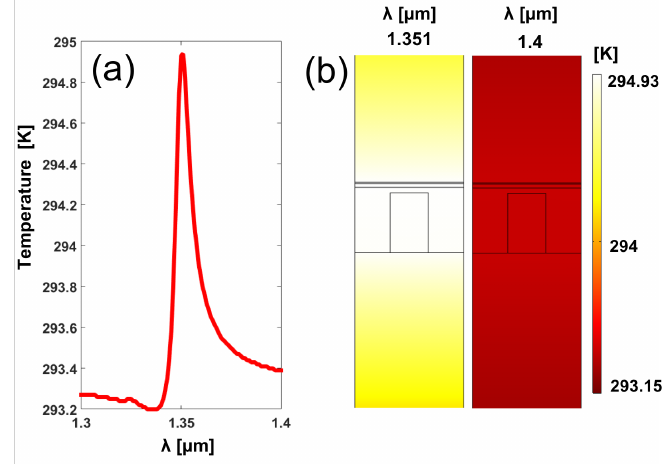
Figure 3. ( a ) Maximum temperature reached at the structure in terms of the wavelength. ( b ) Temperature distribution within the structure for the resonant ( λ = 1.351 µ m) and non-resonant ( λ = 1.400 µ m)